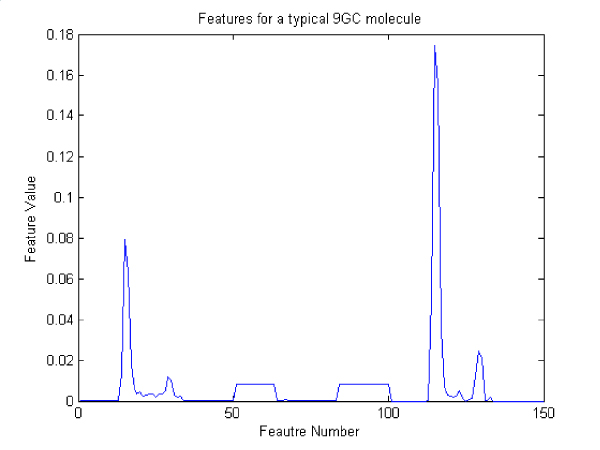
Features for a typical 9GC type molecule.